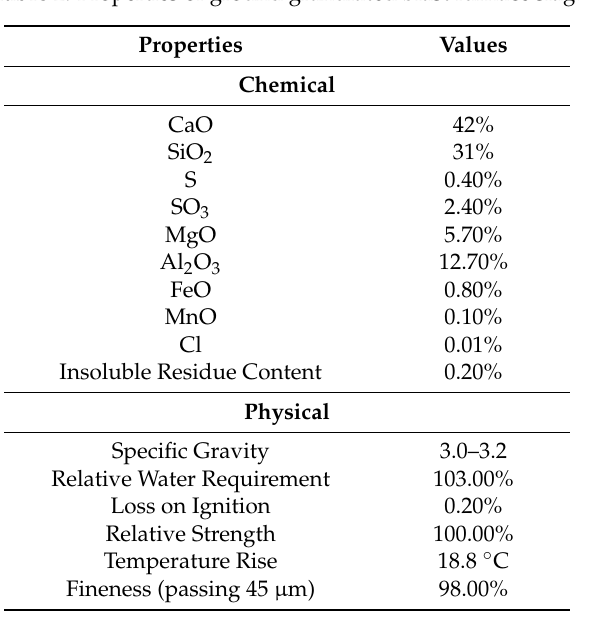
Table 2. Properties of ground granulated blast furnace slag.